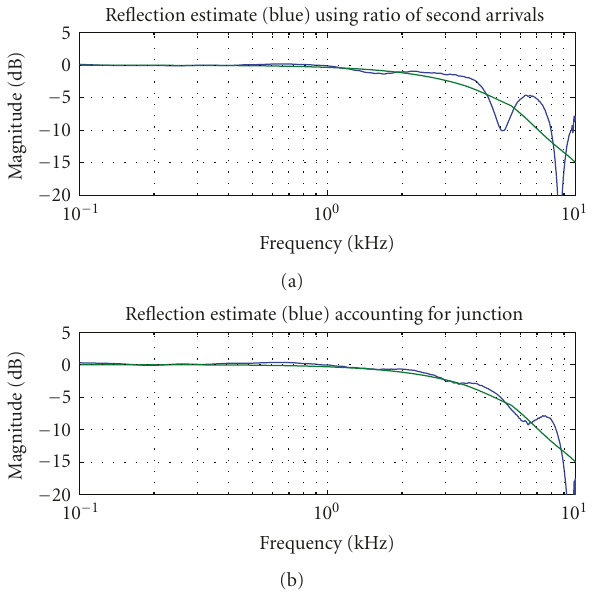
Figure 13: Estimated and theoretical open-end cylinder transmis- sion magnitude as calculated using (13), (a), and by accounting for the junction created by appending a larger radius tube using (20), (b). Notice there is less of a discrepancy between the two methods than was seen for the reflection shown in Figure 12. A slight measurement error is observable at approximately 5kHz, when the signal is higher than